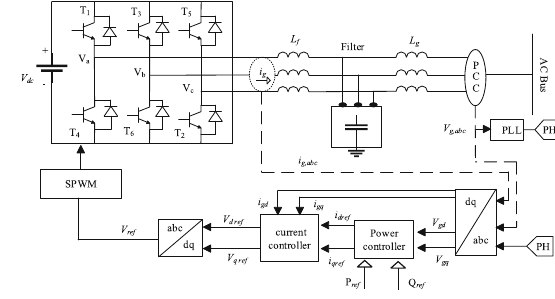
Fig. 1 Parallel structure of micro-grid Fig. 2 Grid-connected PQ control